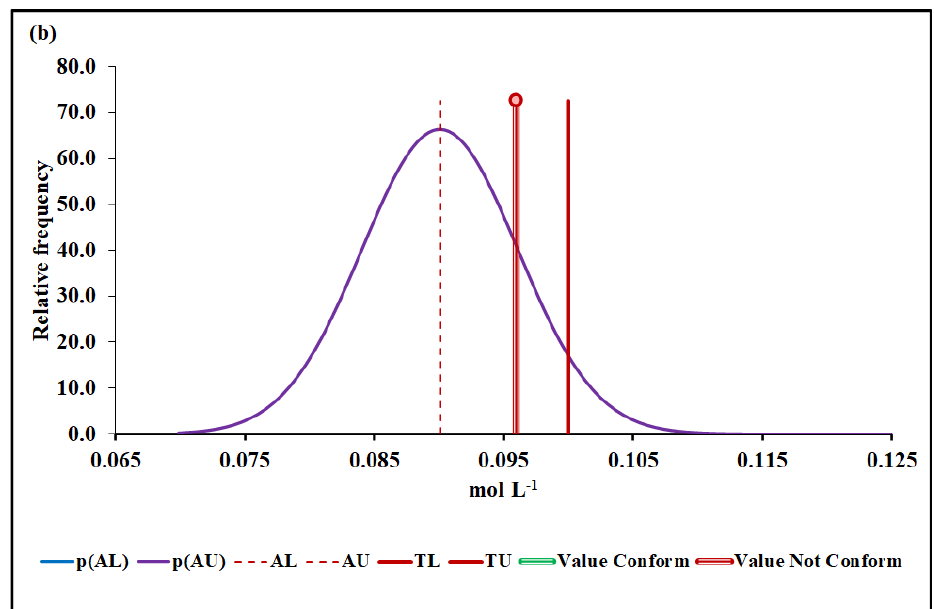
Figure 5. Mn molar concentration conformity assessment based on ( a ) MADe approach and ( b ) nIQR approach. p(AL) − probability density at the lower acceptance limit; p(AU) − probability density at the upper acceptance limit; AL − lower acceptance limit; AU − upper acceptance limit; TL − lower tolerance limit; TU − upper tolerance limit.